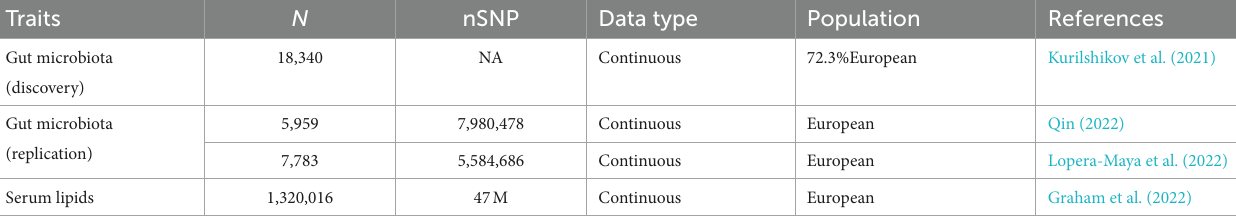
TABLE 1 Summary information of the datasets employed in the current MR study.